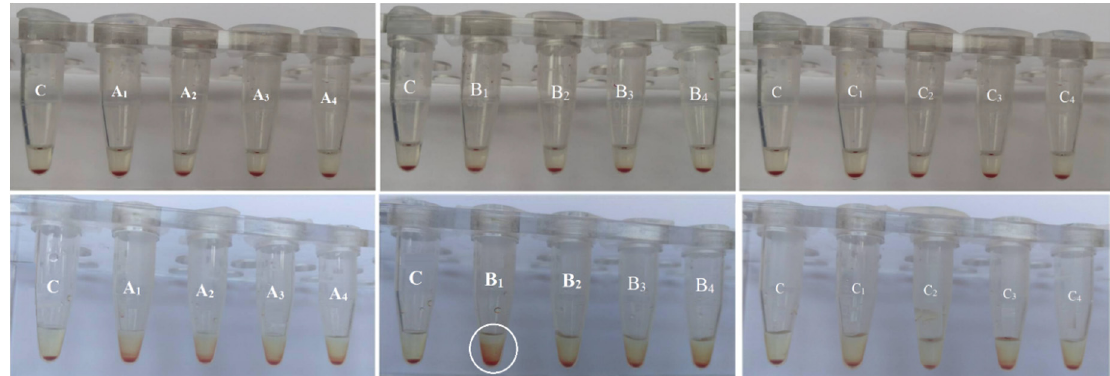
Figure 13. Effect of the nanoapatites: HAp (A 1 ), ClAp (B 1 ) and FAp (C 1 ) as well as nanoapatites doped with Li + (A 2 , B 2 , C 2 ), doped with Eu 3+ (A 3 , B 3 , C 3 ) and co-doped with Eu 3+ /Li + (A 4 , B 4 , C 4 ) ions on the human erythrocytes sedimentation rate at the concentration of 0.1 mg/mL ( top ) and 1 mg/mL ( bottom ) (60 min, 37 °C). C—PBS buffer, n = 3.